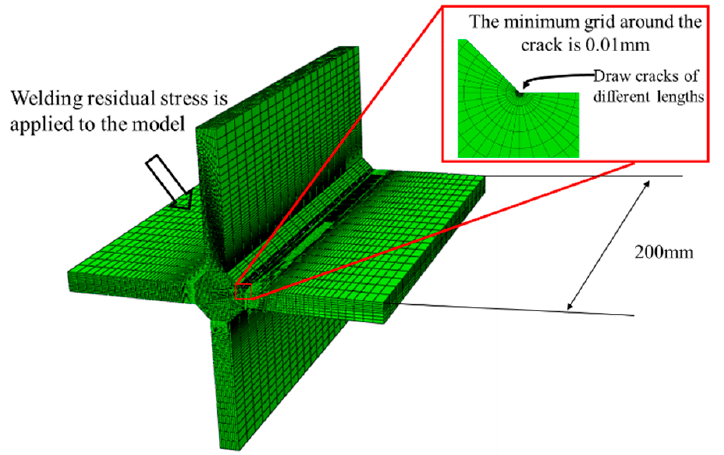
Figure 9. XFEM model of cross joint to obtain stress intensity factor with small crack.